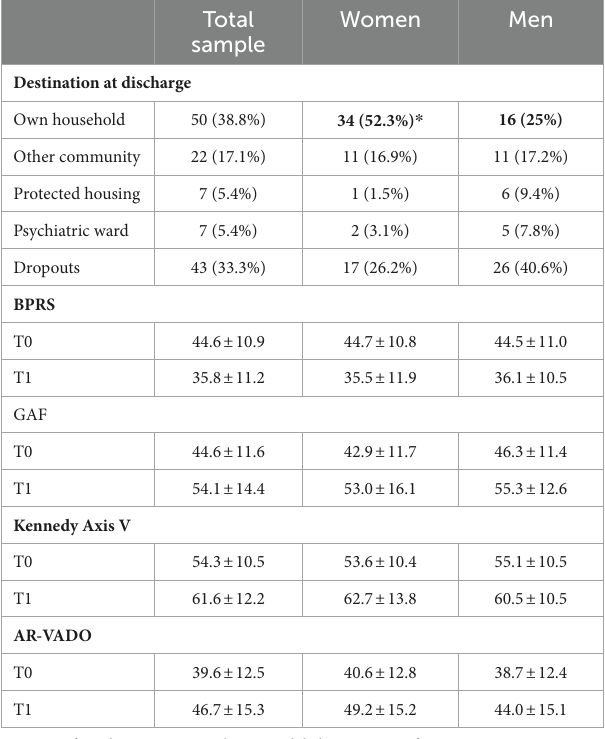
TABLE 2 Outcome measures in the whole sample and their comparison based on